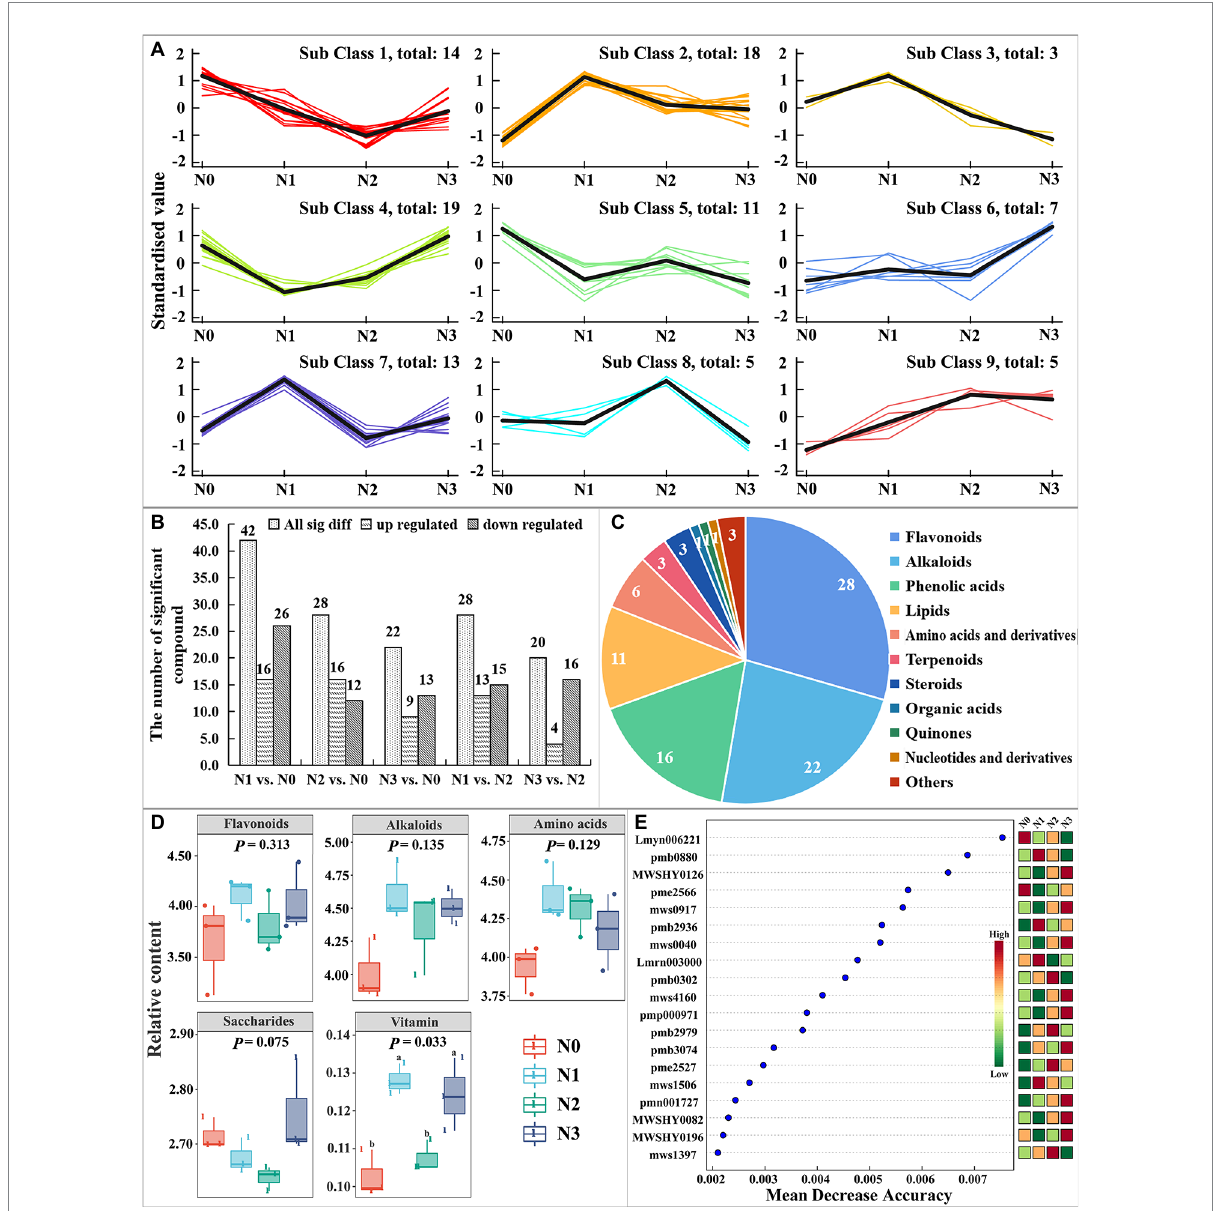
FIGURE 2 Response of the levels of fruit metabolites of Lycium chinensis to experimental N addition based on widely targeted metabolomics